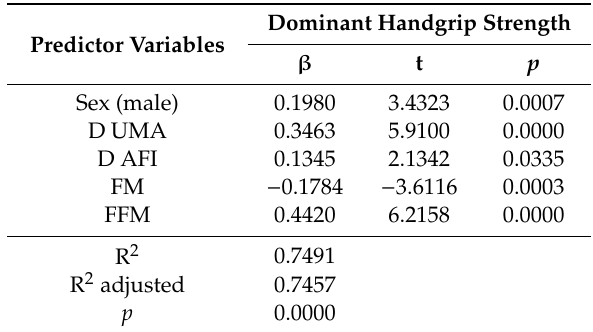
Table 7. Results of multiple linear regression with backward regression